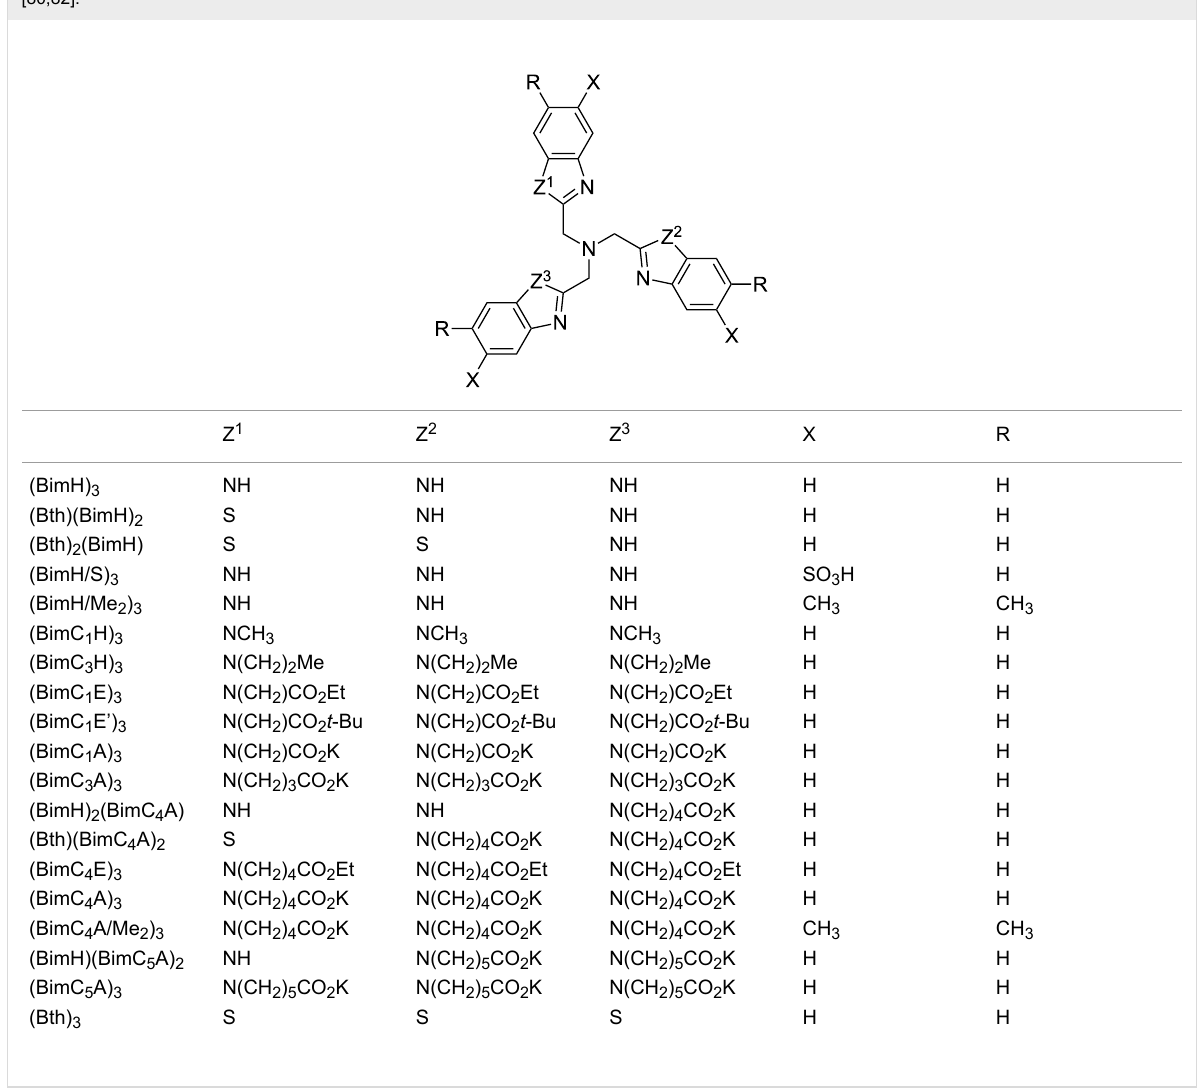
Table 1: Structural variety of tris(heteroarylmethyl)amine ligands synthesized by the group of Finn (the same abbreviations as in the original publica- tion are used: BimY = benzimidazolylmethyl with substituent Y at the N atom; Bth = benzothiazolylmethyl; E = CO 2 Et; E’ = CO 2 t -Bu; A = CO 2 − K + )